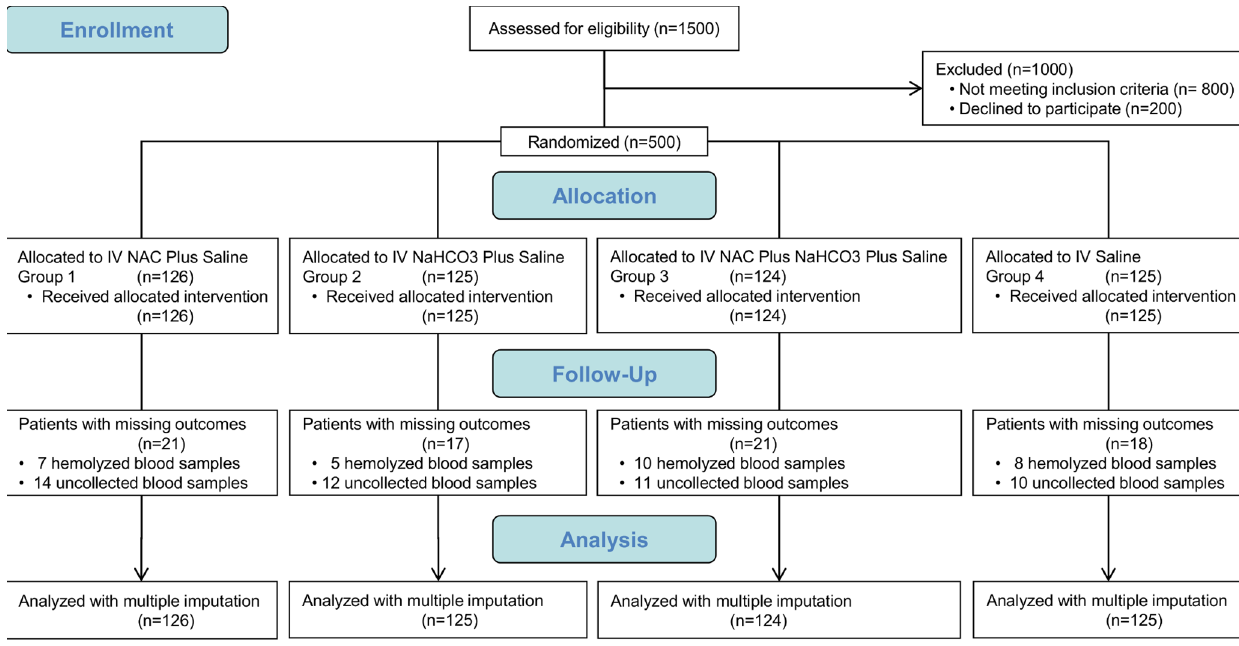
Figure 1. Flow of 500 outpatients through a parallel trial of four treatments for preventing CI-AKI. Practice of the trial design. Abbreviations: CI-AKI (contrast-induced acute kidney injury), IV (intravenous), NAC (N-acetylcysteine), NaHCO3 (sodium bicarbonate).